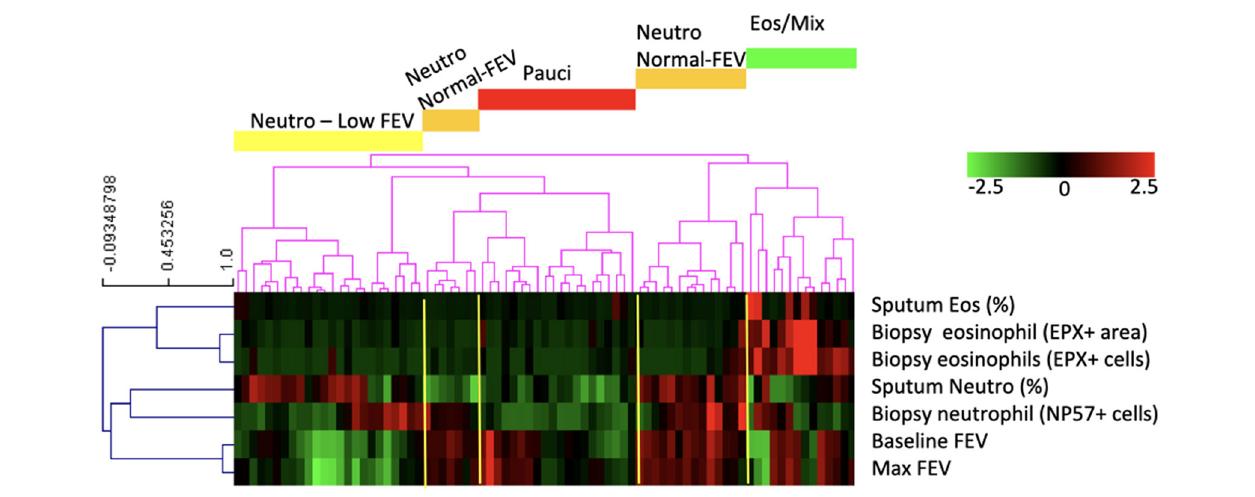
FIGURE 1 | The clustering analysis based on neutrophil and eosinophil counts and lung function resulted in five groups of patients of which four had phenotypically different disease: patients with asthma characterized by mixed eosinophilic/neutrophilic inflammation (Eos/Mix), with neutrophilic asthma with low FEV 1 (Neutro Low FEV), with neutrophilic asthma with normal FEV 1 (Neutro Normal FEV), or with paucigranulocytic asthma (Pauci).